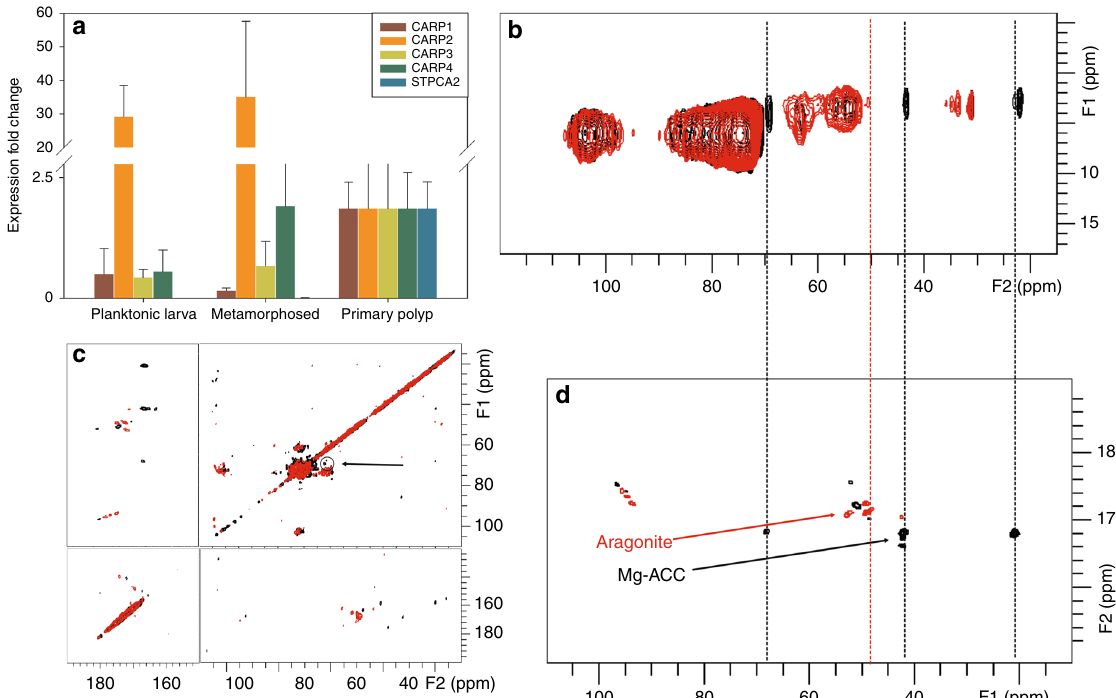
Fig. 5 Identi fi cation of functional protein in the two stages. a qPCR analysis of the relative expression levels of distinct skeletal organic matrix genes determined by the ΔΔ C T method (see Methods section). The expression fold change is relative to the expression in the settled primary polyp stage. All samples were collected in triplicate and the results are presented as the average fold change ± SE, n = 3. b 2D 1 H – 13 C HETCOR spectra of pre-settled metamorphosed planula (black) and primary polyp (red). Spectra were recorded using a contact time of 2 ms, recycle delay of 1 s, and 4000 scans. c 2D 13 C DARR NMR spectra of the entire pre-settled metamorphosed planulae (black) and entire primary polyps (red). The 2D DARR spectra show a large diagonal ridge and several off-diagonal peaks, appearing as dots in the 2D maps. These peaks indicate magnetization transfers between two different carbons. The peak at (F2, F1):(62, 68) encircled and marked by the arrow, indicates the magnetization transfer between threonine C β – C α carbons. It is unique and characteristic of a protein with Thr prevalent in its sequence. d 2D 13 C DARR (carbonate region) – – blow-up of the carbonate region (upper left fraction in Fig. 5c rotated 90° counterclockwise) showing the strong correlations of the organic carbons with the disordered mineral phase at 169.5 ppm in the pre-settled planula metamorphosed and the weak correlations with the disordered aragonite at 171 ppm in the primary polyp. Dashed lines correlate common carbons peaks in the HETCOR ( b ) and in the DARR spectra ( d